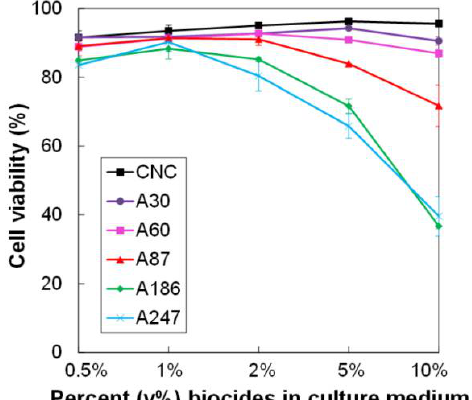
Figure 4. Evolution at various incubation times (48, 96, 120, 168 h) of inhibition halos of CNC/AgNP hybrids at two different initial AgNP contents (8.7 and 24.7 wt% Ag) with and without H 2 O 2 redox post-treatment.